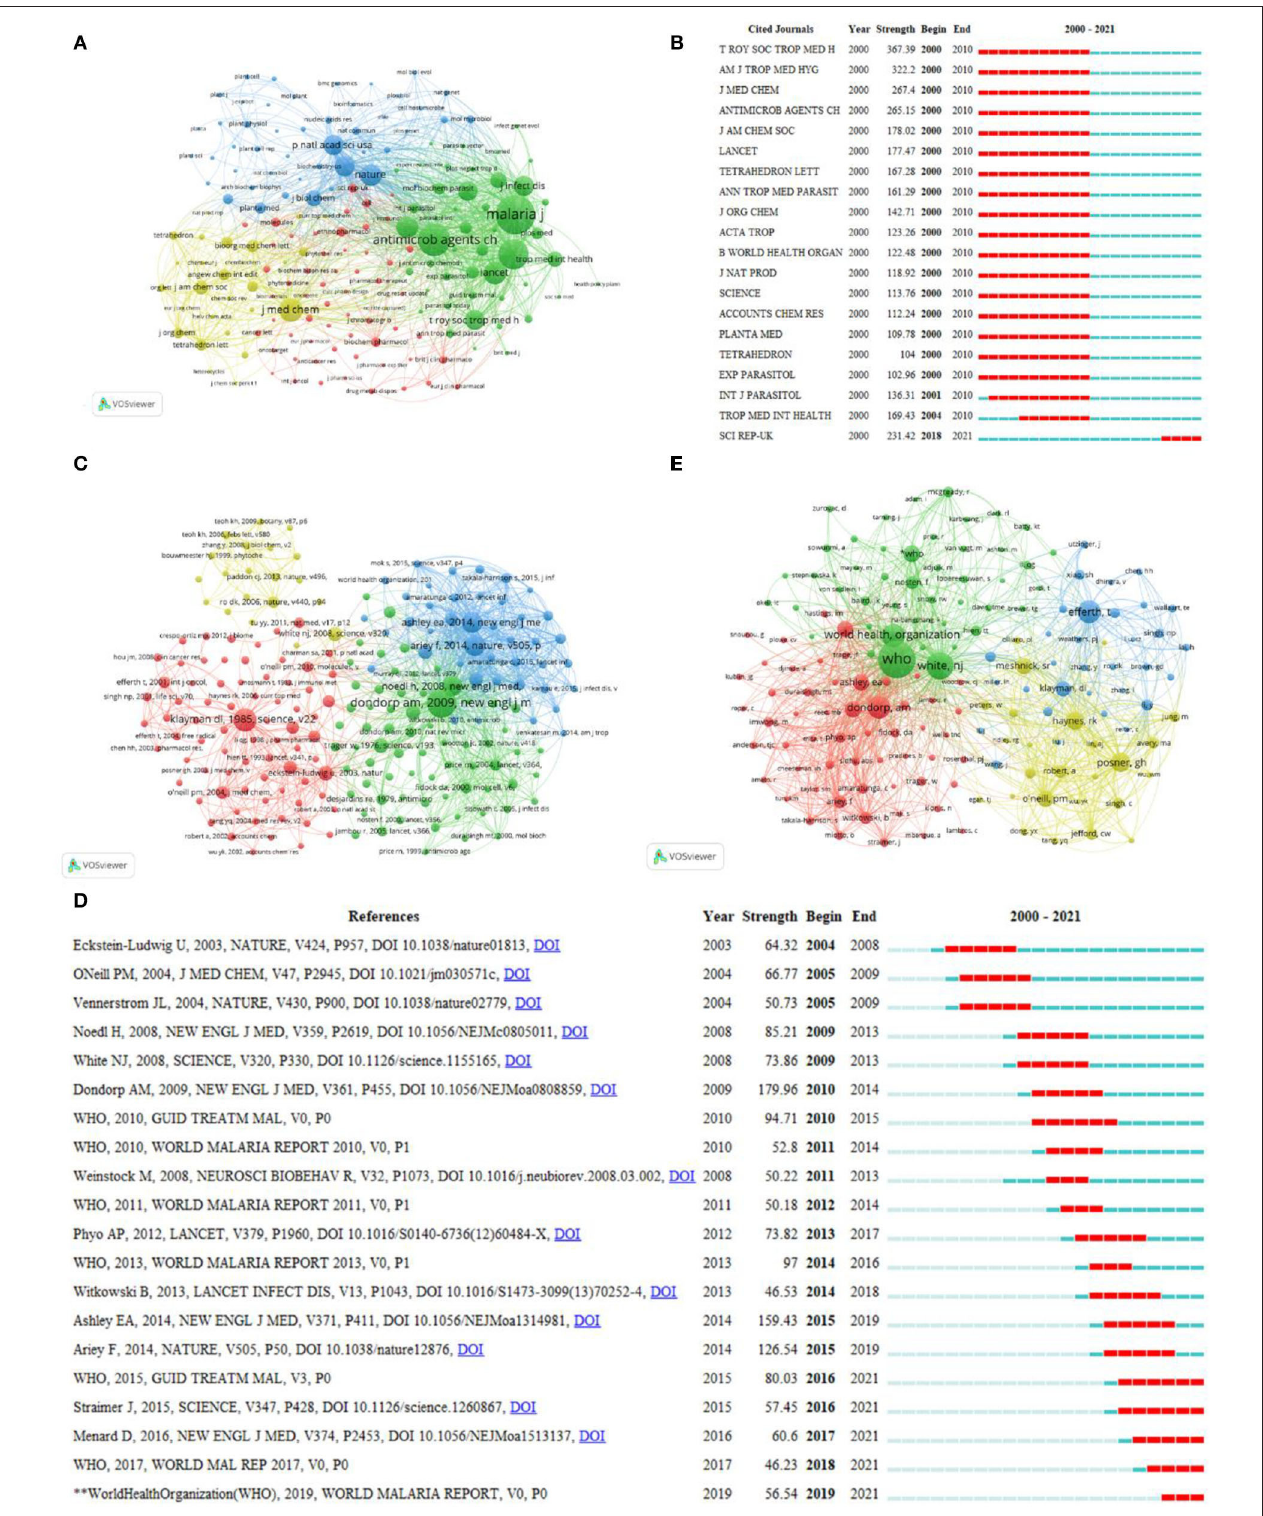
FIGURE 5 | Visualization of the cited journal, co-cited reference, and co-cited author analysis. (A) Co-occurrence network of cited journals. (B) Top 20 representative burst cited journals. (C) Co-occurrence network of co-cited reference. (D) Top 20 representative burst co-cited references. (E) Co-occurrence network of the co-cited